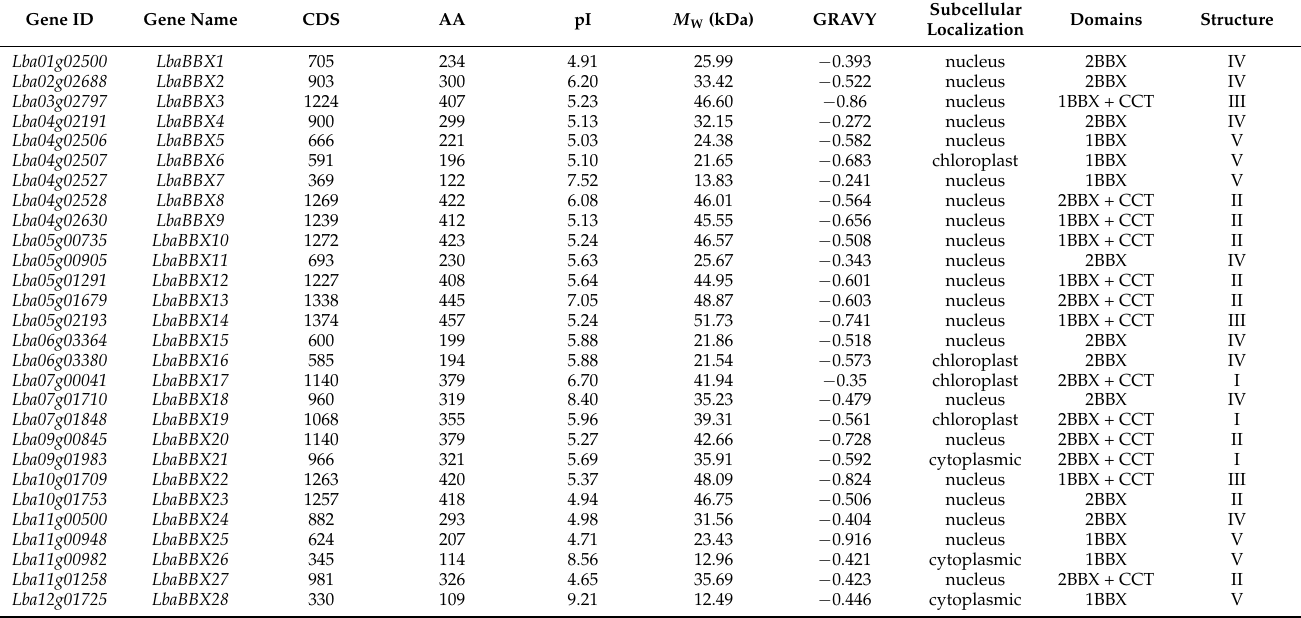
Table 1. Information on the BBX gene family in